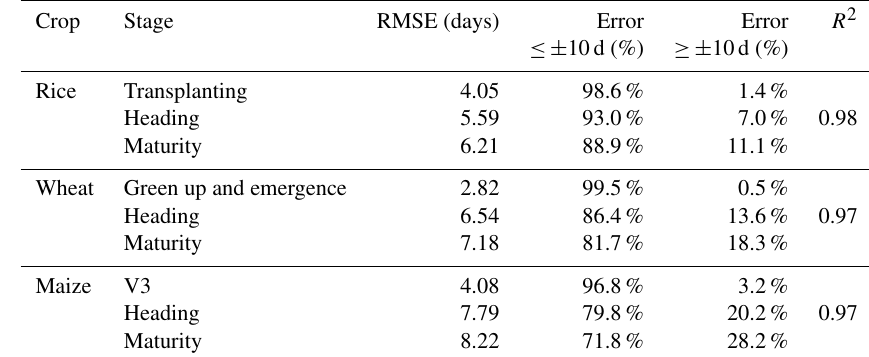
Table 2. Mean RMSE between retrieved phenological dates and phenological observations.